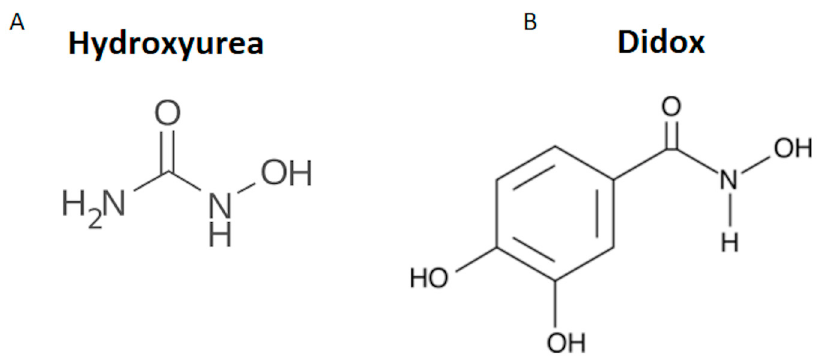
Figure 1. Chemical structure of hydroxyurea and its derivative didox. The structure of hydroxyurea (HU) ( A ) has been modified to obtain that one of didox ( B ) in which the amino group of HU has been substituted by a catechol group.